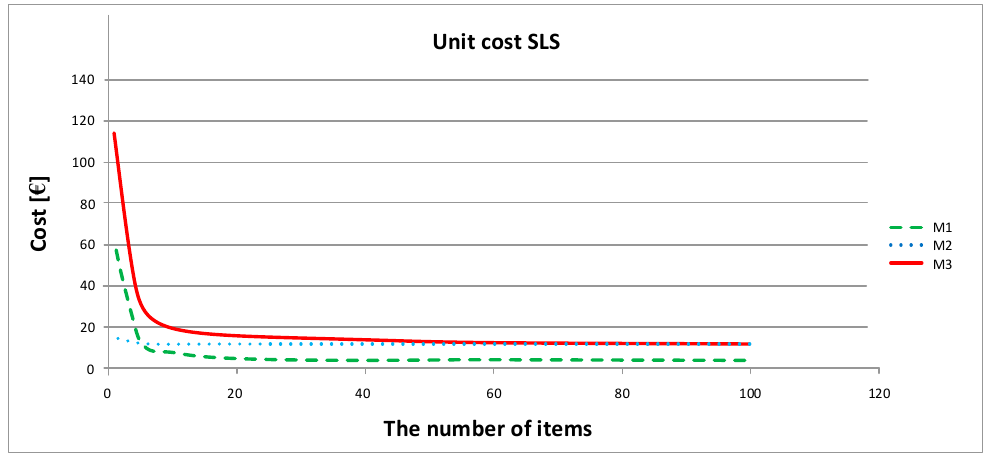
Figure 14. Dependence of the bracket production costs on the number of prototypes for SLS technology.